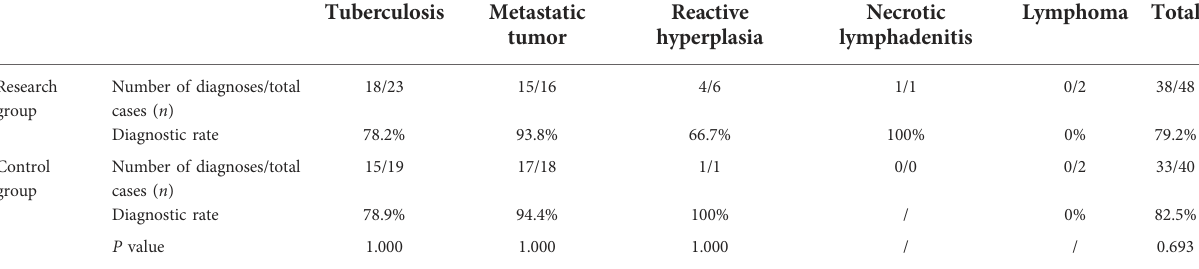
TABLE 2 Comparison of pathological diagnosis results between the two groups.